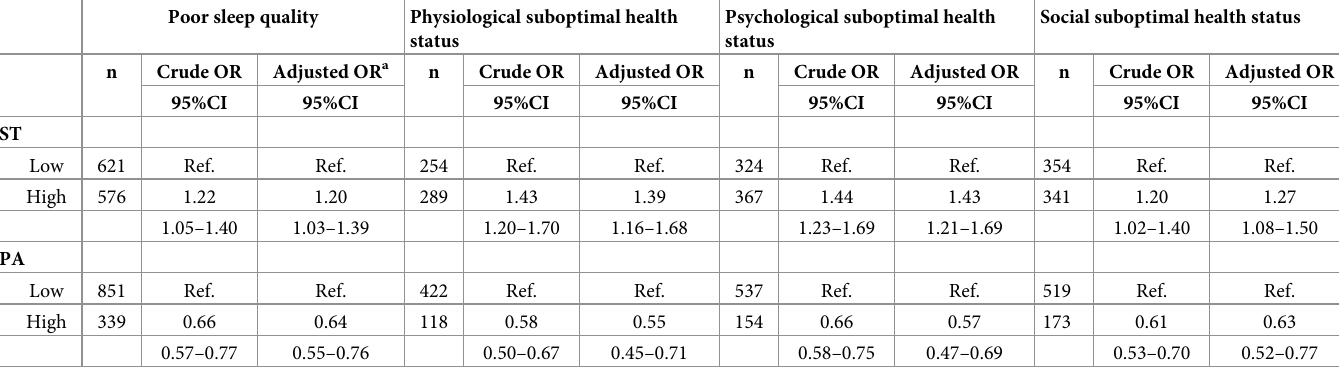
Table 2. Associations between ST, PA and sleep quality, and physiological, psychological, and social suboptimal health status.